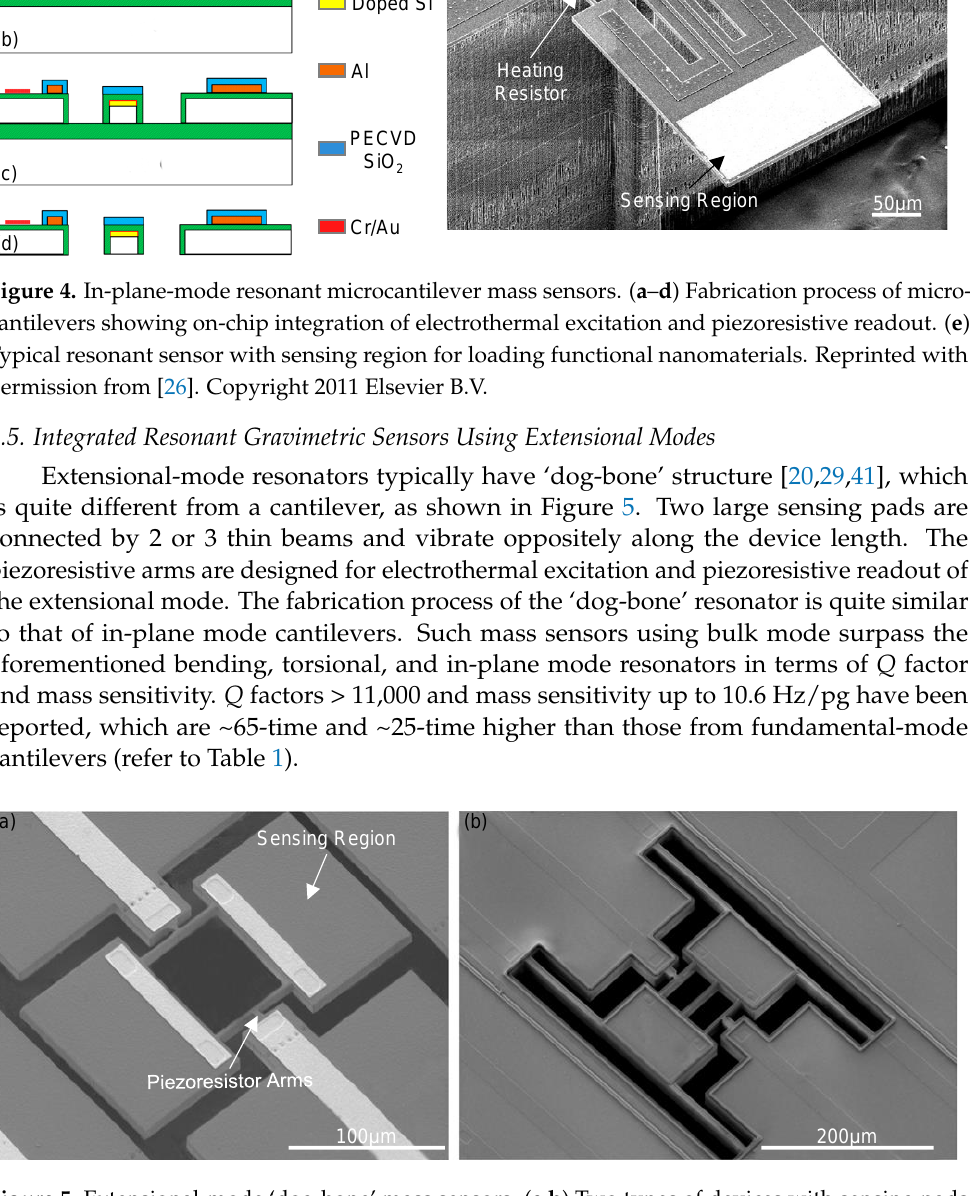
Figure 5. Extensional-mode ‘dog-bone’ mass sensors. ( a , b ) Two types of devices with sensing pads connected by dual- and tri-beams. Reprinted with permission from [20]. Copyright 2016 IEEE.